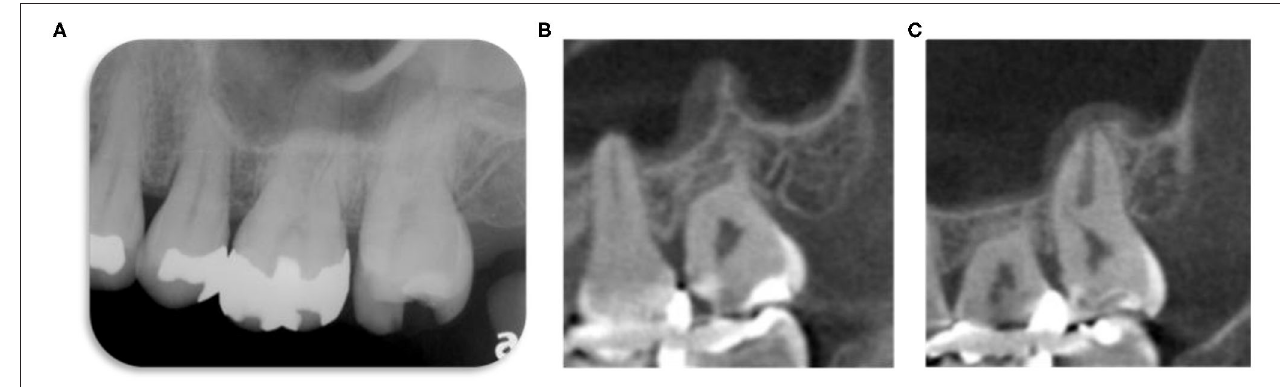
FIGURE 1 | Radiographic image taken during the patient’s initial visit to the University Clinic. (A) Intraoral radiographic image. The maxillary left second molar with the restoration already removed. No abnormal findings were discovered on any other teeth. There seems to be a sufficient distance between the restoration and the pulp ( ≤ 5mm), but this remains ambiguous. (B) Selected sagittal images of cone-beam computed tomography (CBCT) volume. Three-dimensional evaluation by CBCT shows that the mesial filling is close to the mesial pulp horn. (C) Sagittal images of CBCT. Thickening of the maxillary sinus mucosa is seen, but the relationship with the maxillary left second molar remains